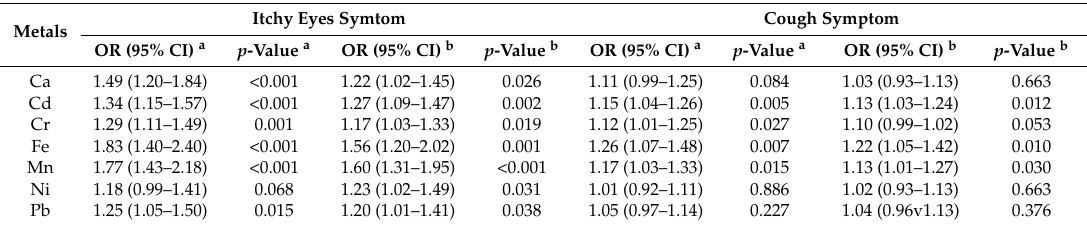
Table 3. Adjusted odds ratio and 95% confidence intervals for itchy eyes and cough symptom associated with level of heavy metals’ concentrations.